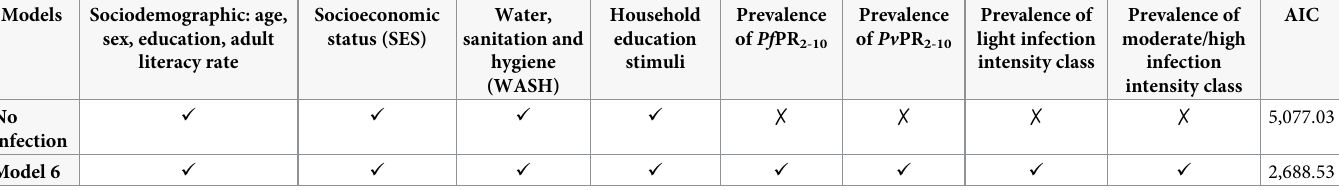
Table 4. List of covariates included in the models, Mindanao (infection intensity